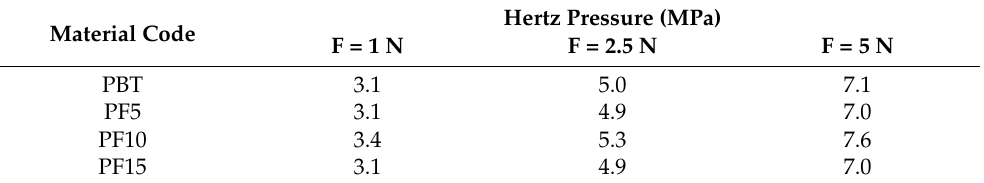
Table 2. Hertz pressure for linear contact of the tested blocks made of PBT and PBT + PTFE blends.